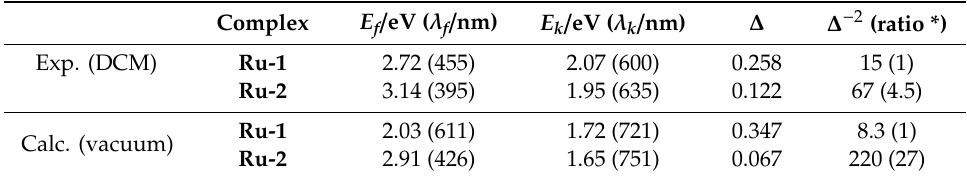
Table 3. Estimation of the detuning factor ( ∆ ) and enhancement factor ( ∆ taken from the experimental and calculated results. (DCM =